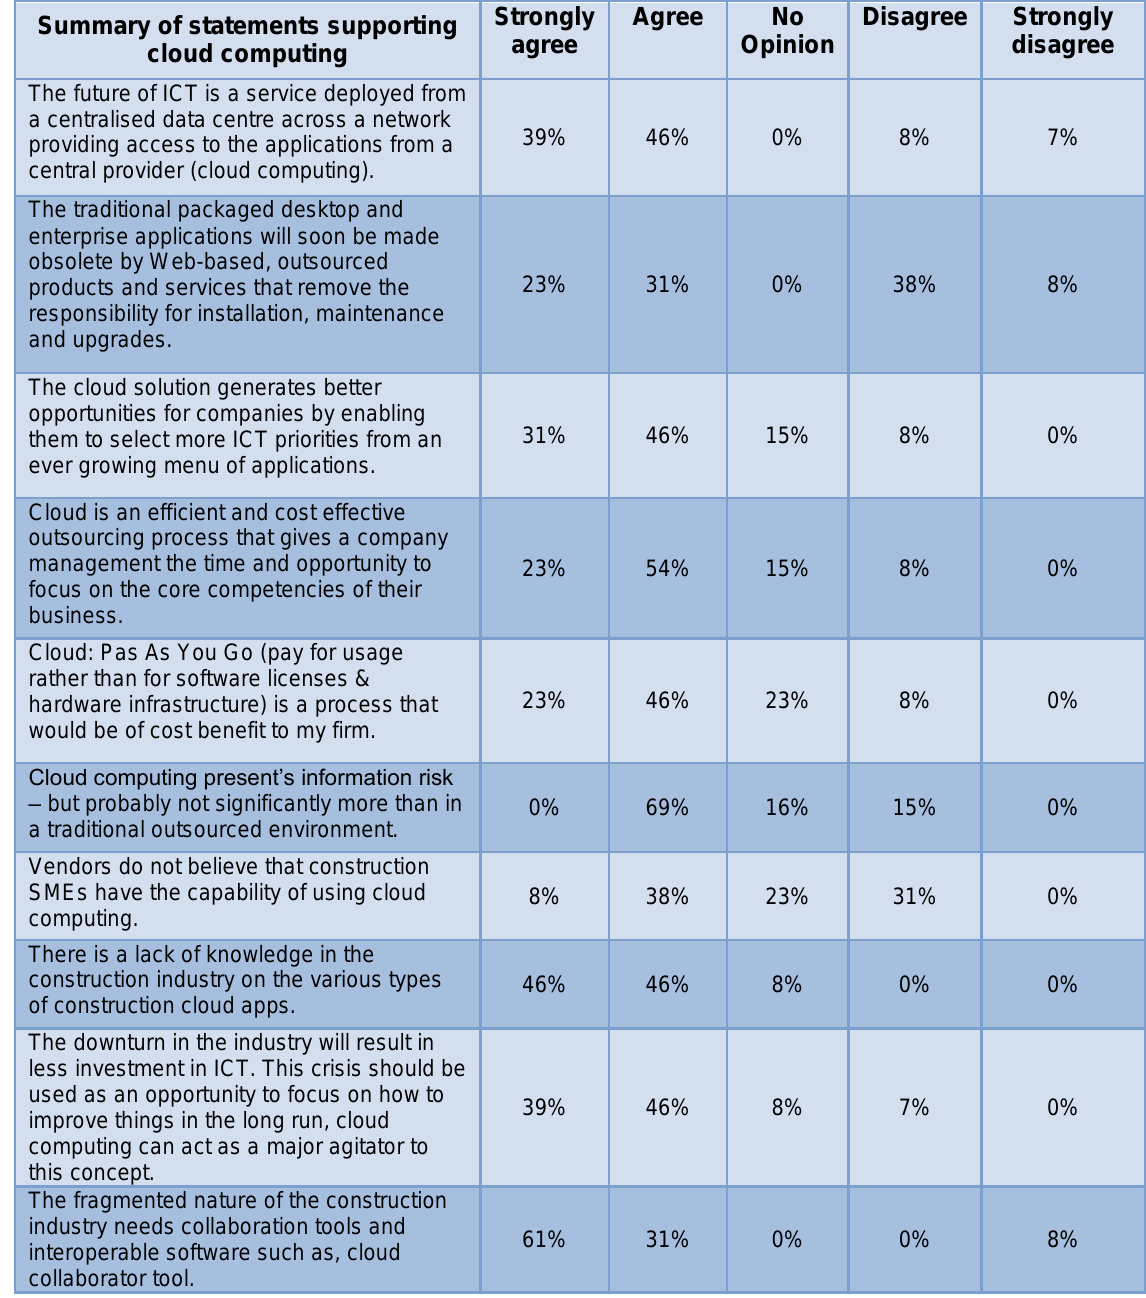
Table 1 Summary of statements supporting cloud